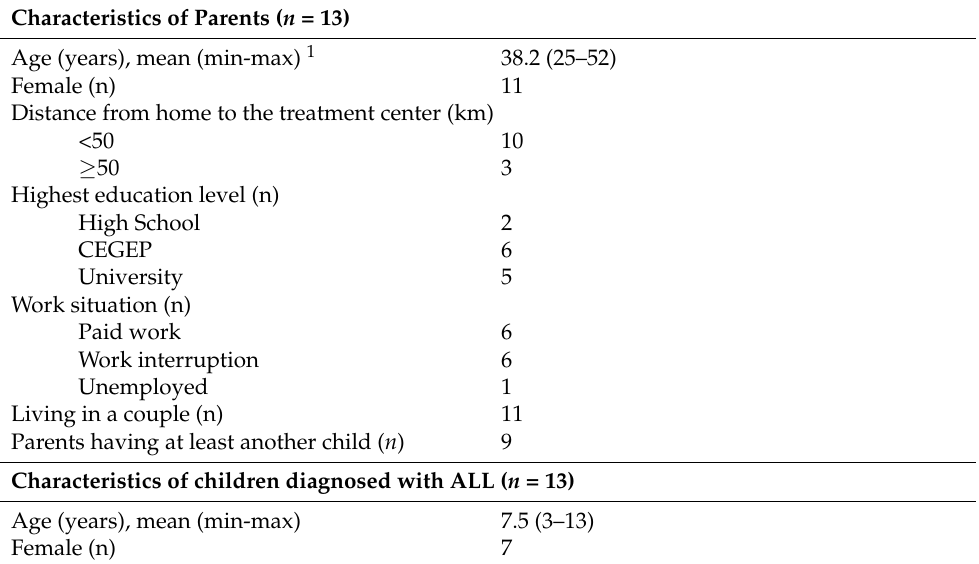
Table 1. Parents’ and children’s characteristics.